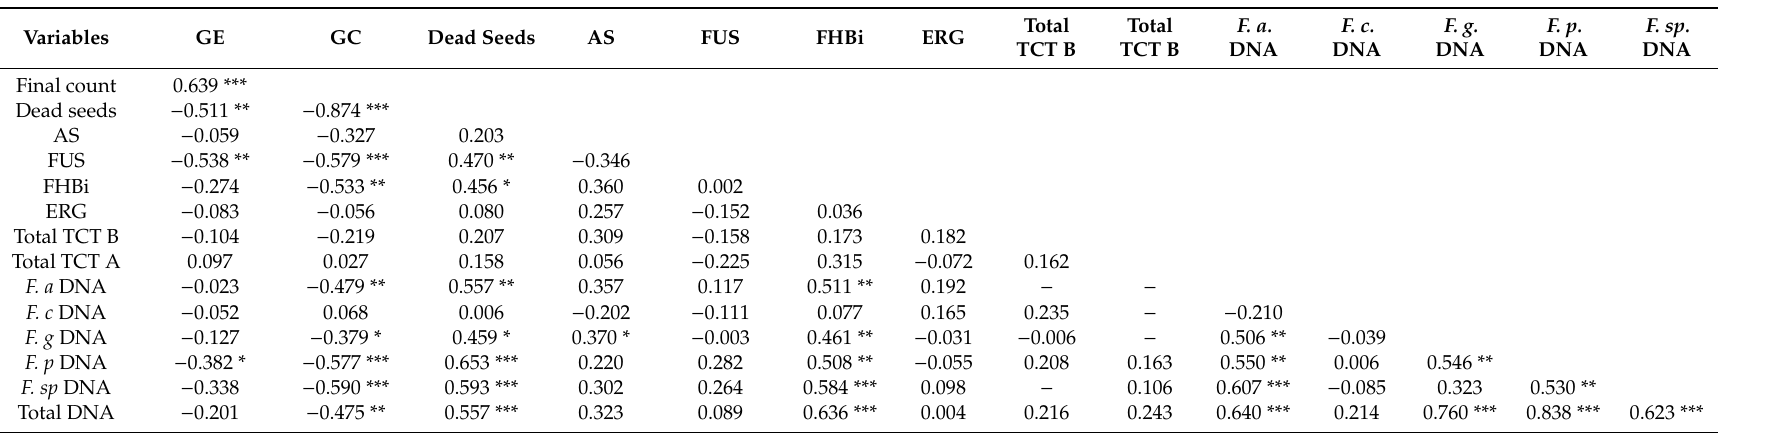
Table 8. Coe ffi cients of correlations between seed quality parameters (germination energy—GE, germination capacity—GC, dead seeds, abnormal seedling—AS, fresh ungerminated seeds—FUS) and Fusarium head blight index (FHBi), ergosterol (ERG) and type A and B trichothecenes concentrations (Total TCT A, Total TCT B) as well as amount of DNA of five Fusarium species in grain samples from organic